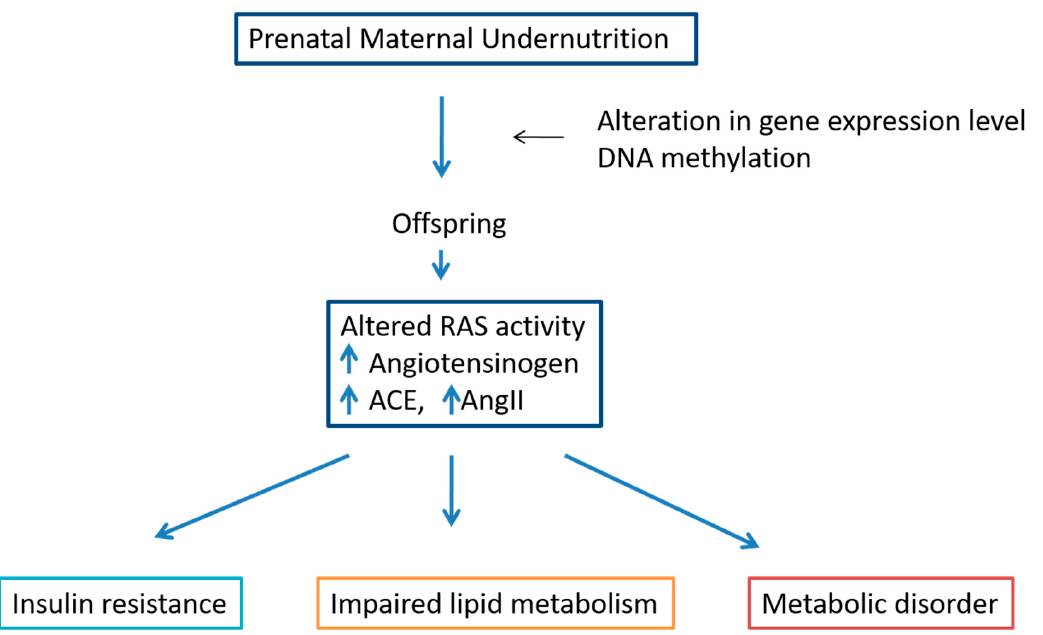
Figure 6. Effect of prenatal undernutrition on RAS. Prenatal undernutrition has linked with sub- stantial changes in RAS components of offspring resulting in impaired lipid and carbohydrate me-